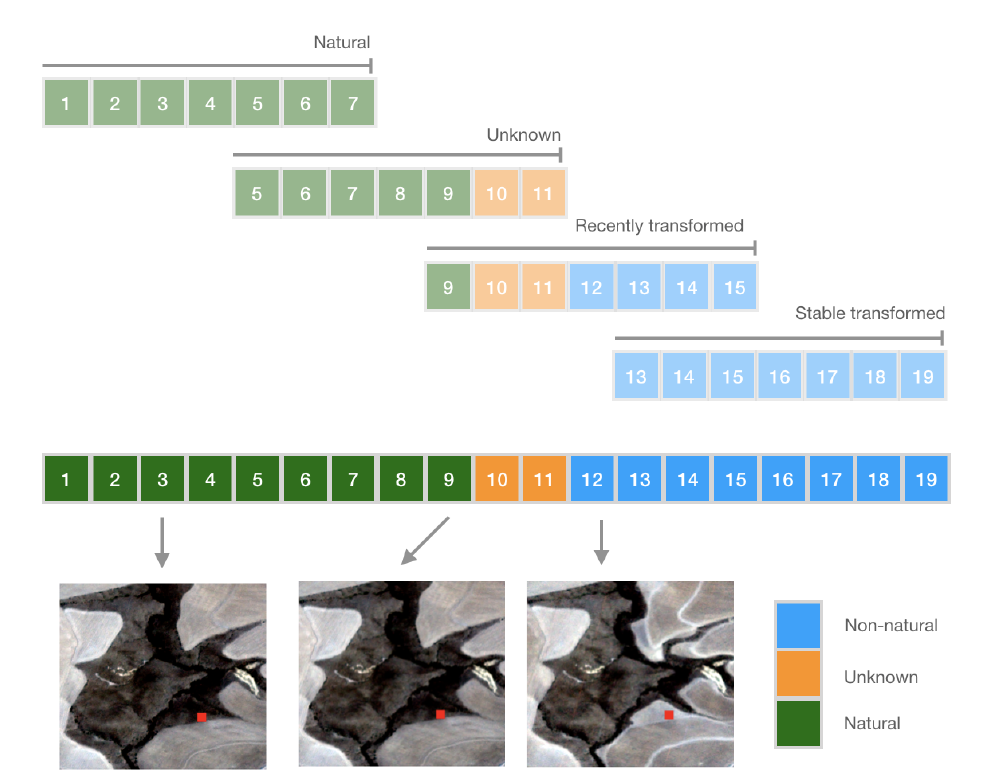
Figure 1. The approach used for labelling time series’ to enable continuous classification of change. Each step in the sequence of 19 observations represents an observation obtained for a single pixel at a regular interval (e.g., 10 days). The land cover label for the pixel (identified by the red point in the images) can either be natural, unknown or non-natural. This label is obtained through inspection of time series of Planet Labs Planetscope satellite imagery. For the example pixel indicated here, an image obtained at step 3 indicates that the land cover is natural on this date. The image at step 9 indicates the last date on which natural land cover is observed. The first time at which non-natural land cover is observed is at step 12. Hence, it is not known whether the land cover was natural or non-natural at step 10 and 11. Using a window length of 7 observations and forward step of 4, 4 labelled sequences can be extracted from the full time series. Each sequence is assigned the label of the most recent observation and used to train and evaluate machine learning classifiers. These models can then be applied continuously as new data become available to produce near-real-time land cover change